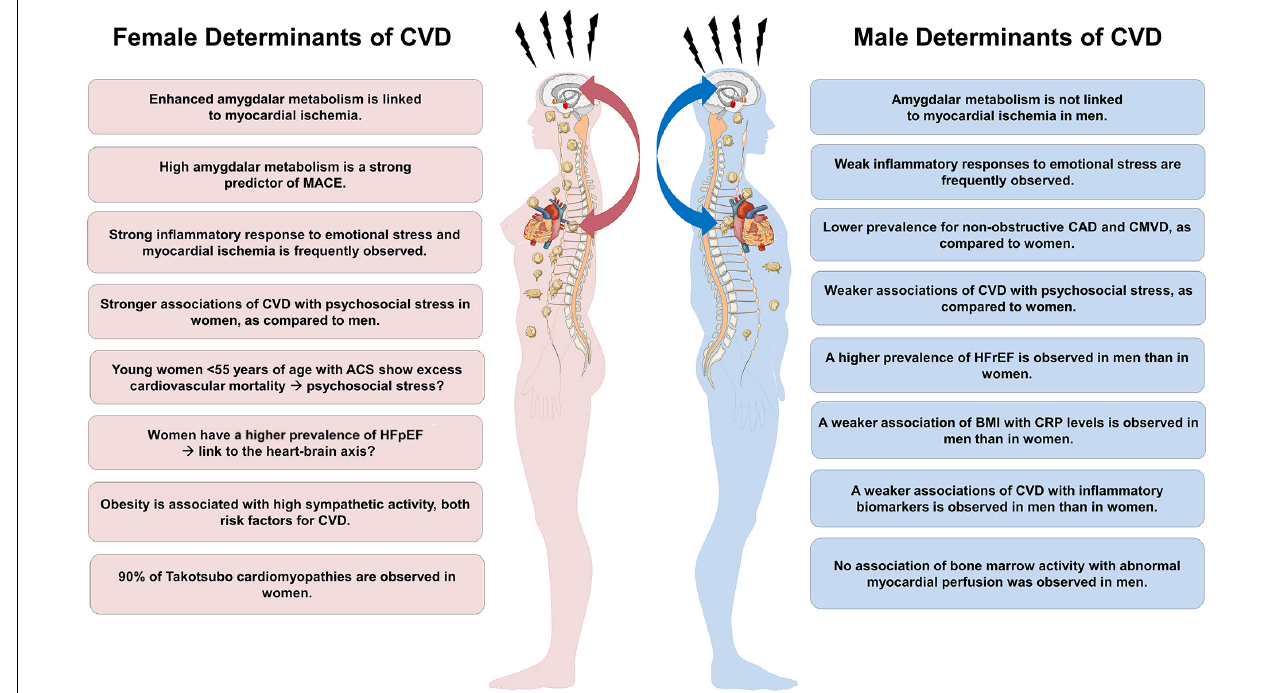
FIGURE 1 | Potential involvement of the heart-brain axis in sex-dependent risk factors and presentations of cardiovascular disease (CVD). BMI, body mass index; CAD, coronary artery disease; CMVD, coronary microvascular dysfunction; CRP, C-reactive protein; MACE, major adverse cardiac events; ACS, acute coronary syndromes; HFpEF, heart failure with preserved ejection fraction; HFrEF, heart failure with reduced ejection fraction.